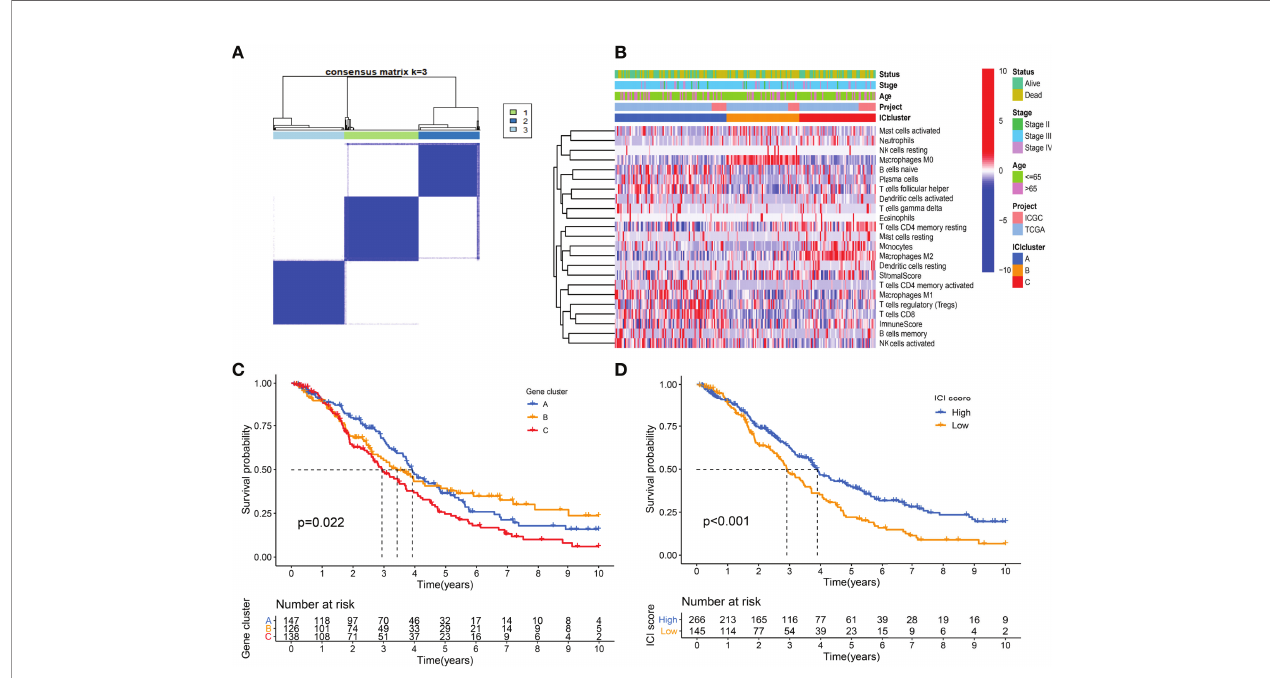
FIGURE 4 | Landscape of differentially expressed gene clusters. (A) Unsupervised consensus clustering. (B) Characteristics of DEGs expression levels and clinical features in different clusters. (C) Kaplan-Meier curve of gene clusters with log-rank test P = 0.022. (D) Kaplan-Meier curve of gene clusters with log-rank test P <